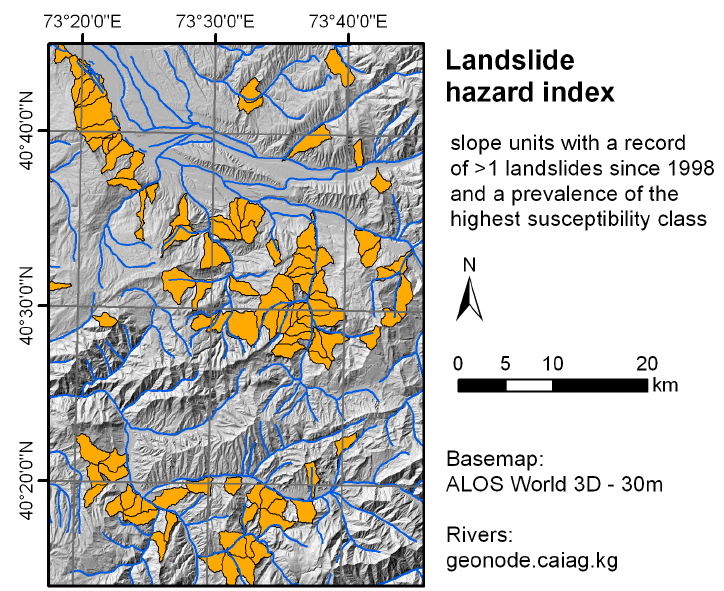
Figure 9. Slope units with the highest landslide hazard index, i.e., slope units where (i) more than one landslide failure occurred since 1998 and (ii) the highest susceptibility tertile occupies a larger area than any other